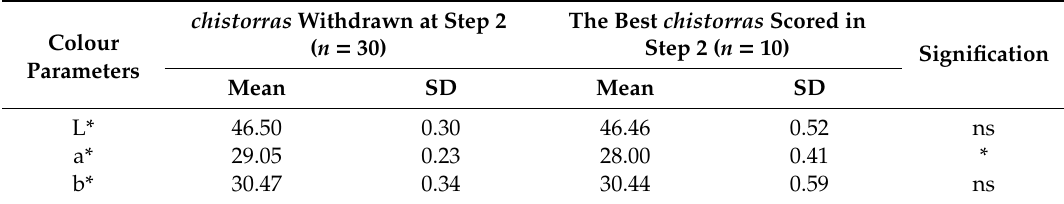
Table 6. Instrumental colour results of chistorras in phase 2. Data were grouped in: 10 best